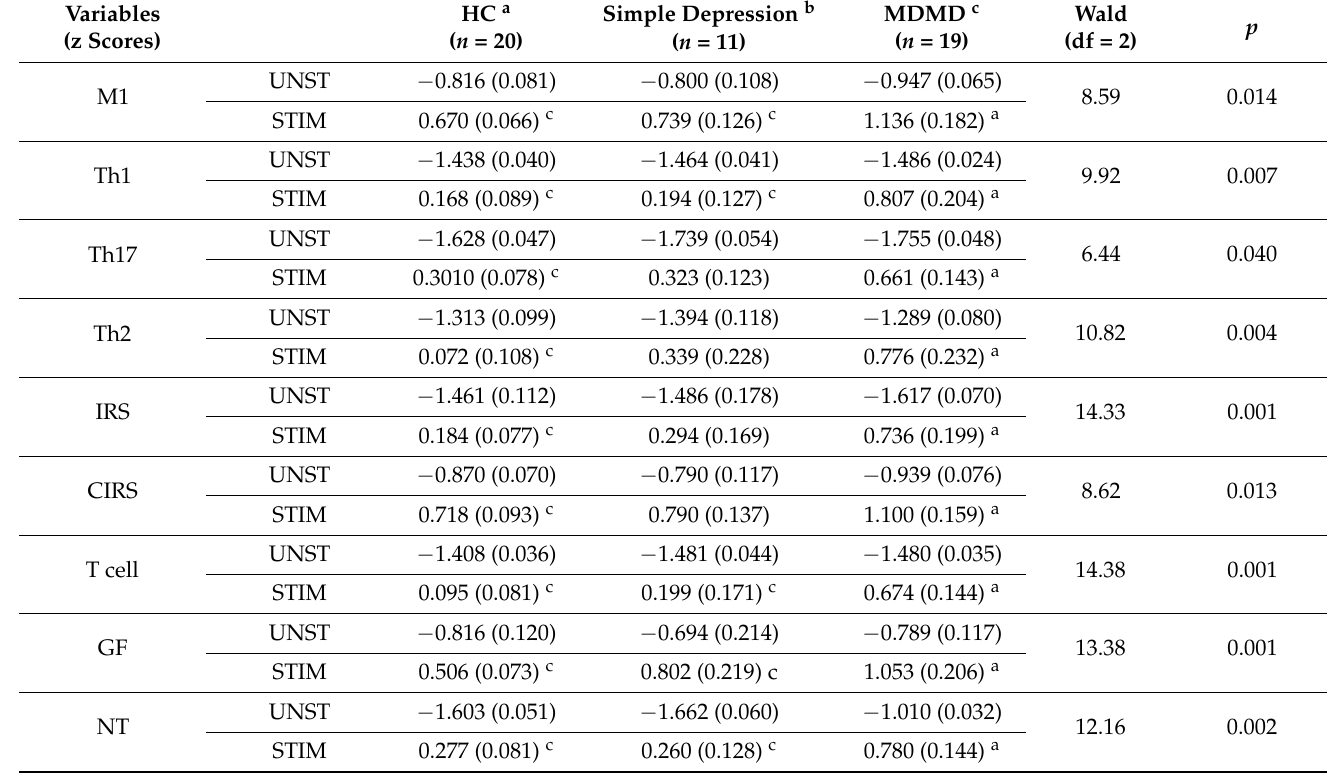
Table 2. Differences in unstimulated (UNST) and lipopolysaccharide + phytohemagglutinin- stimulated (STIM) changes in various immune profiles in healthy controls (HC) and depressed patients, divided into those with simple depression and major dysmood disorder (MDMD).